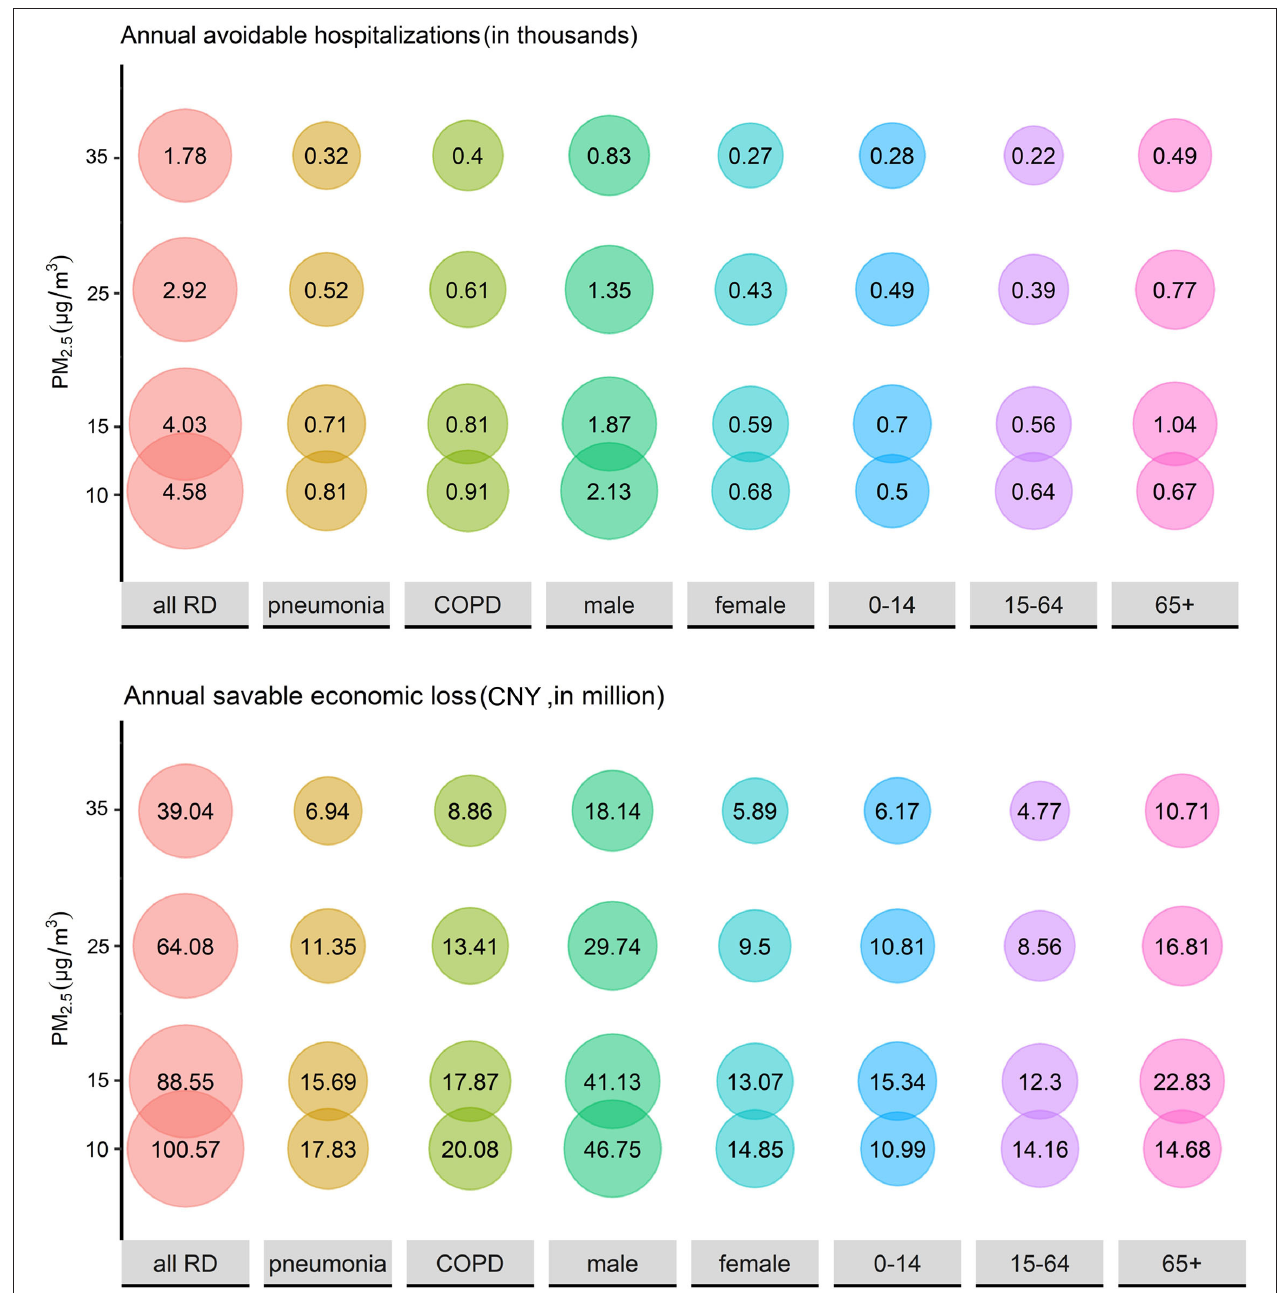
FIGURE 5 | The estimated annual avoidable hospitalizations and savable economic losses if the historical concentration of PM 2.5 could be maintained at relatively low